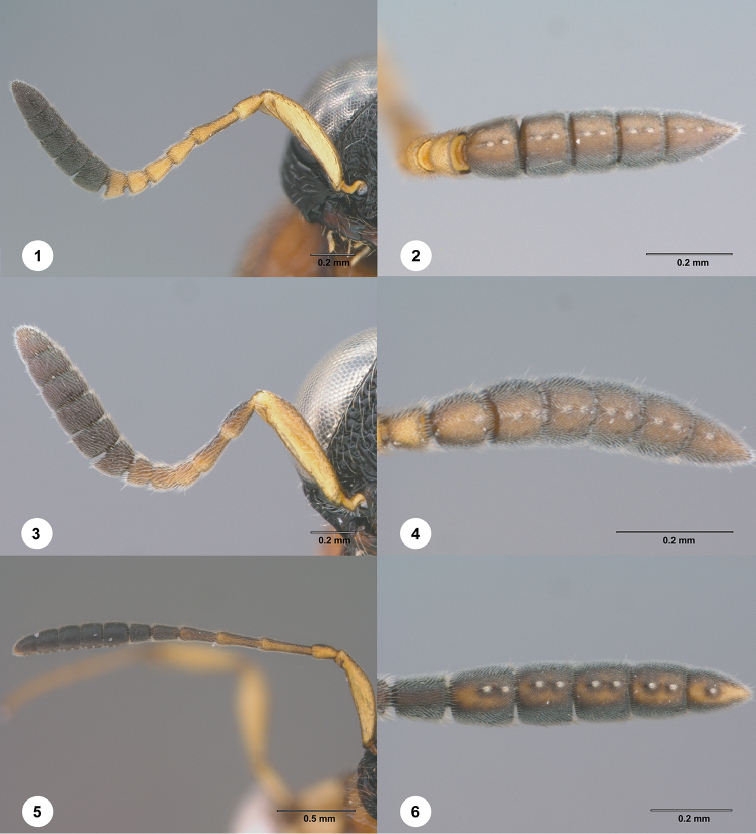
1–2Chromoteleiatricarinata Kieffer, female (OSUC268814). 1 Antenna 2 Antennal clava, ventral view 3–4Chromoteleiaparvitas sp. n., holotype, female (OSUC276182) 3 Antenna 4 Antennal clava, ventral view 5–6Chromoteleialonga sp. n., holotype, female (OSUC320643) 5 Antenna 6 Antennal clava, ventral view.